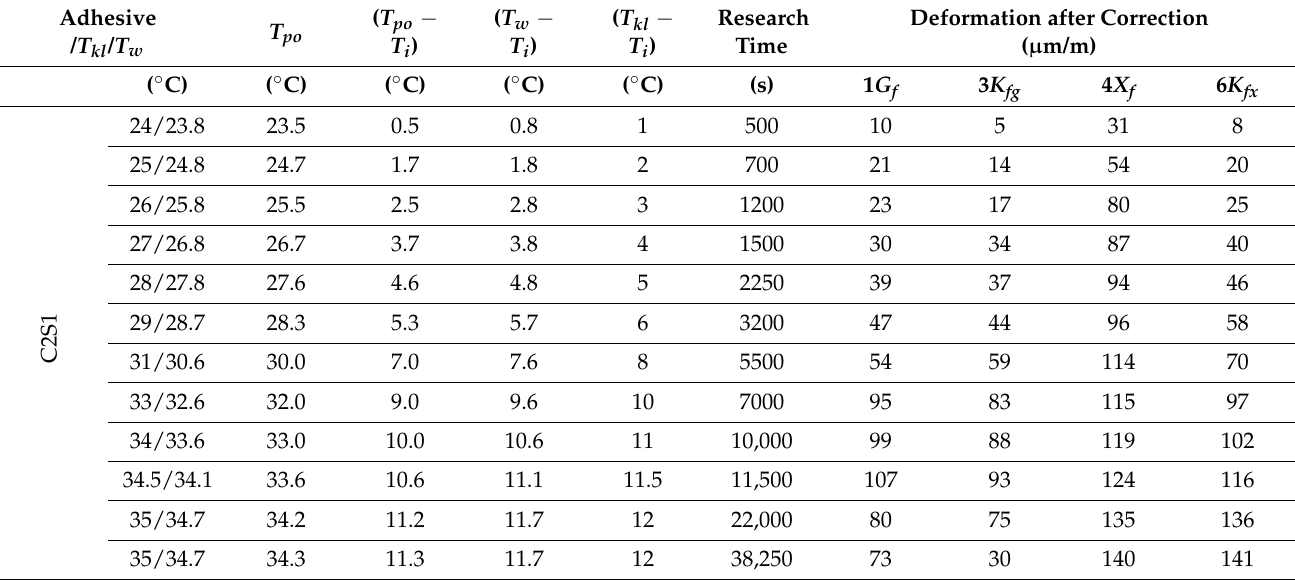
Table 1. Data of material deformation taking the corrections of strain gauges with C2S1 adhesive (average air temperature T i = 23 ◦ C, max adhesive temperature on the sensor T kl = 35 ◦ C).